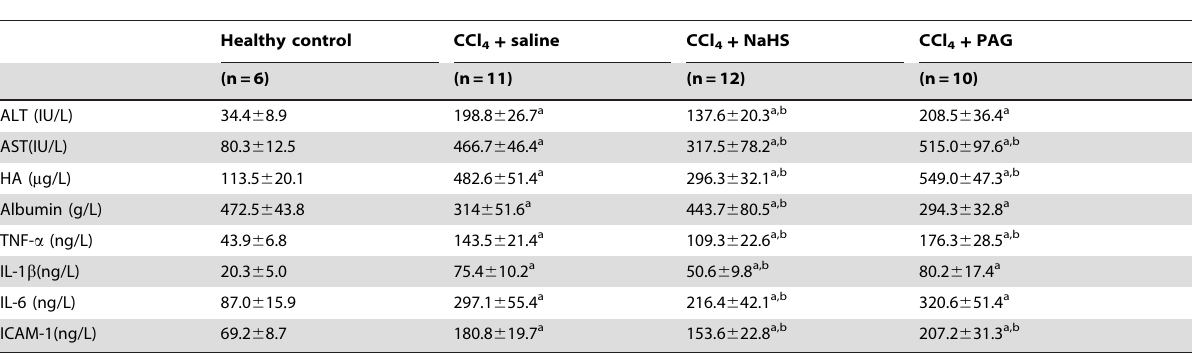
Table 2. Serum biochemicals and inflammatory factors in cirrhotic rats*.